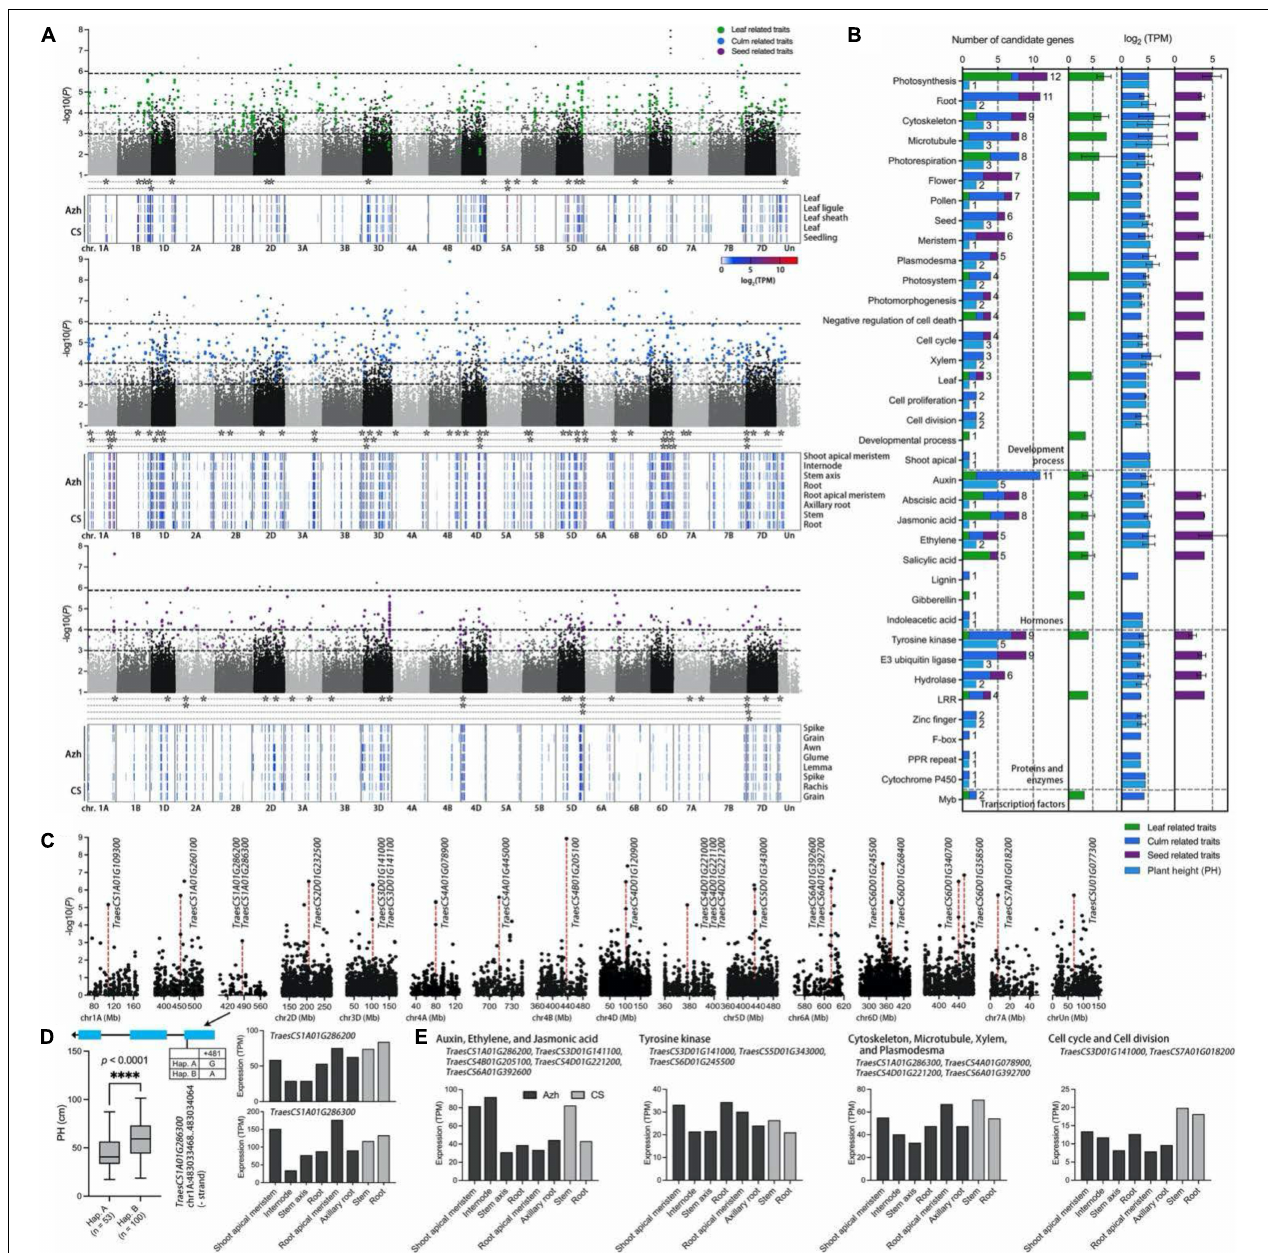
FIGURE 5 | Genome-wide association study for phenotypic traits and identification of the candidate genes for the significant SNPs. (A) Manhattan plot for leaf (green points)-, culm (blue points)-, and seed (purple points)-related traits in E. sibiricus , respectively. Only SNPs with P values smaller than.1 are plotted. Three horizontal dashed lines represent P values at of 1.13e-6, 1e-4, and 1e-3, respectively. The gene expression profiles of Azhurnaya and Chinese Spring in leaf-, culm-, and seed-related traits were shown on the heatmap. The stars (*) represent the candidate genes with an expression (TPM) value of more than 10. (B) Frequency of category annotations and average TPM value for candidate genes. The green, blue, purple, and wathet blue bars represent leaf, culm, seed, and plant height (PH) traits, respectively. (C) Local Manhattan plot for PH. The red dashed lines indicate the significant loci with the highest –lg(P) value. (D) Exon–intron structure and DNA polymorphism of TraesCS1A01G286300 . The difference between the two haplotypes was shown on the boxplots and statistically analyzed based on Welch’s test for plant height (PH, 2018). The expression profiles of two candidate genes were shown on the bar plots. (E) The expression profiles of twelve candidate genes were identified from PH